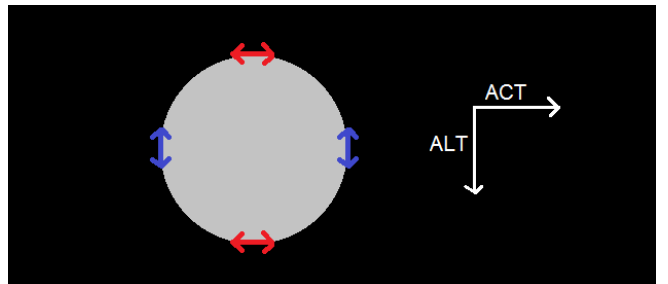
Figure 3. Synthetic representation of the OLCI-B moon observation showing the interfaces between bright and dark zone, which are aligned with along-track (ALT) direction (blue arrows) or across-track (ACT) direction (red arrows).